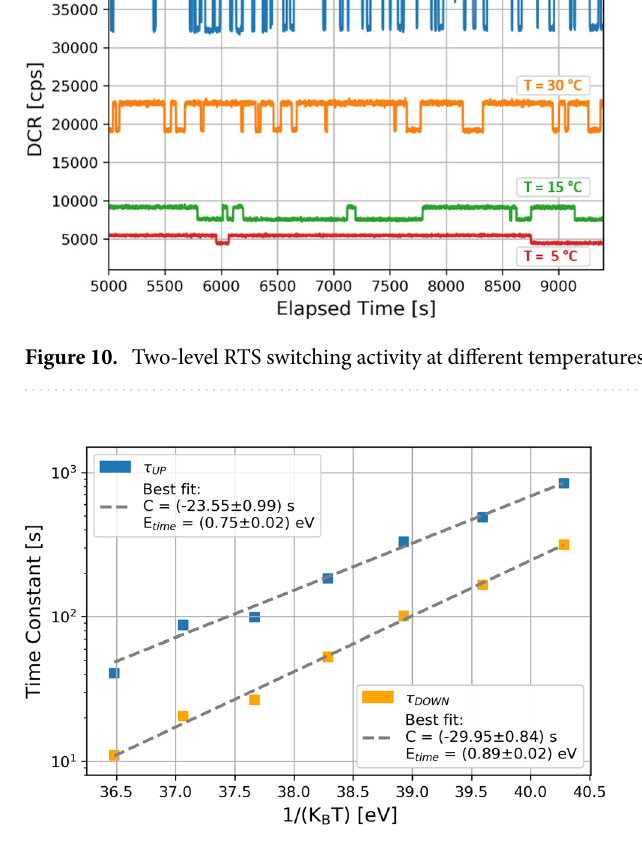
Figure 11. RTS time constants (for up and down levels) as a function of 1 / K B T and the extracted values for the activation energy E time .